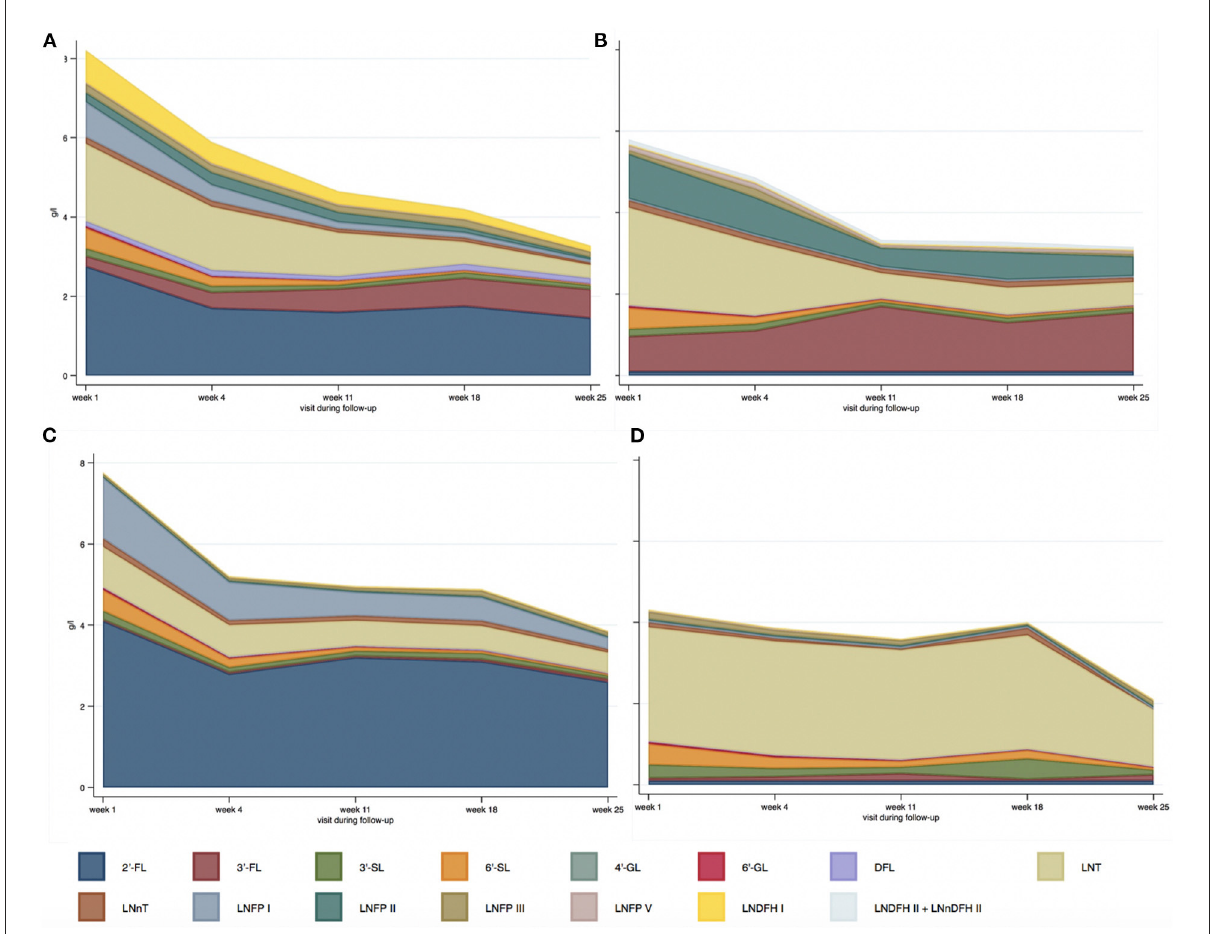
FIGURE3 Median absolute values of HMOs (g/l) depending on human milk-type across lactation period [ (A) HM-type I; (B) HM-type II; (C) HM-type III; (D) HM-type IV].